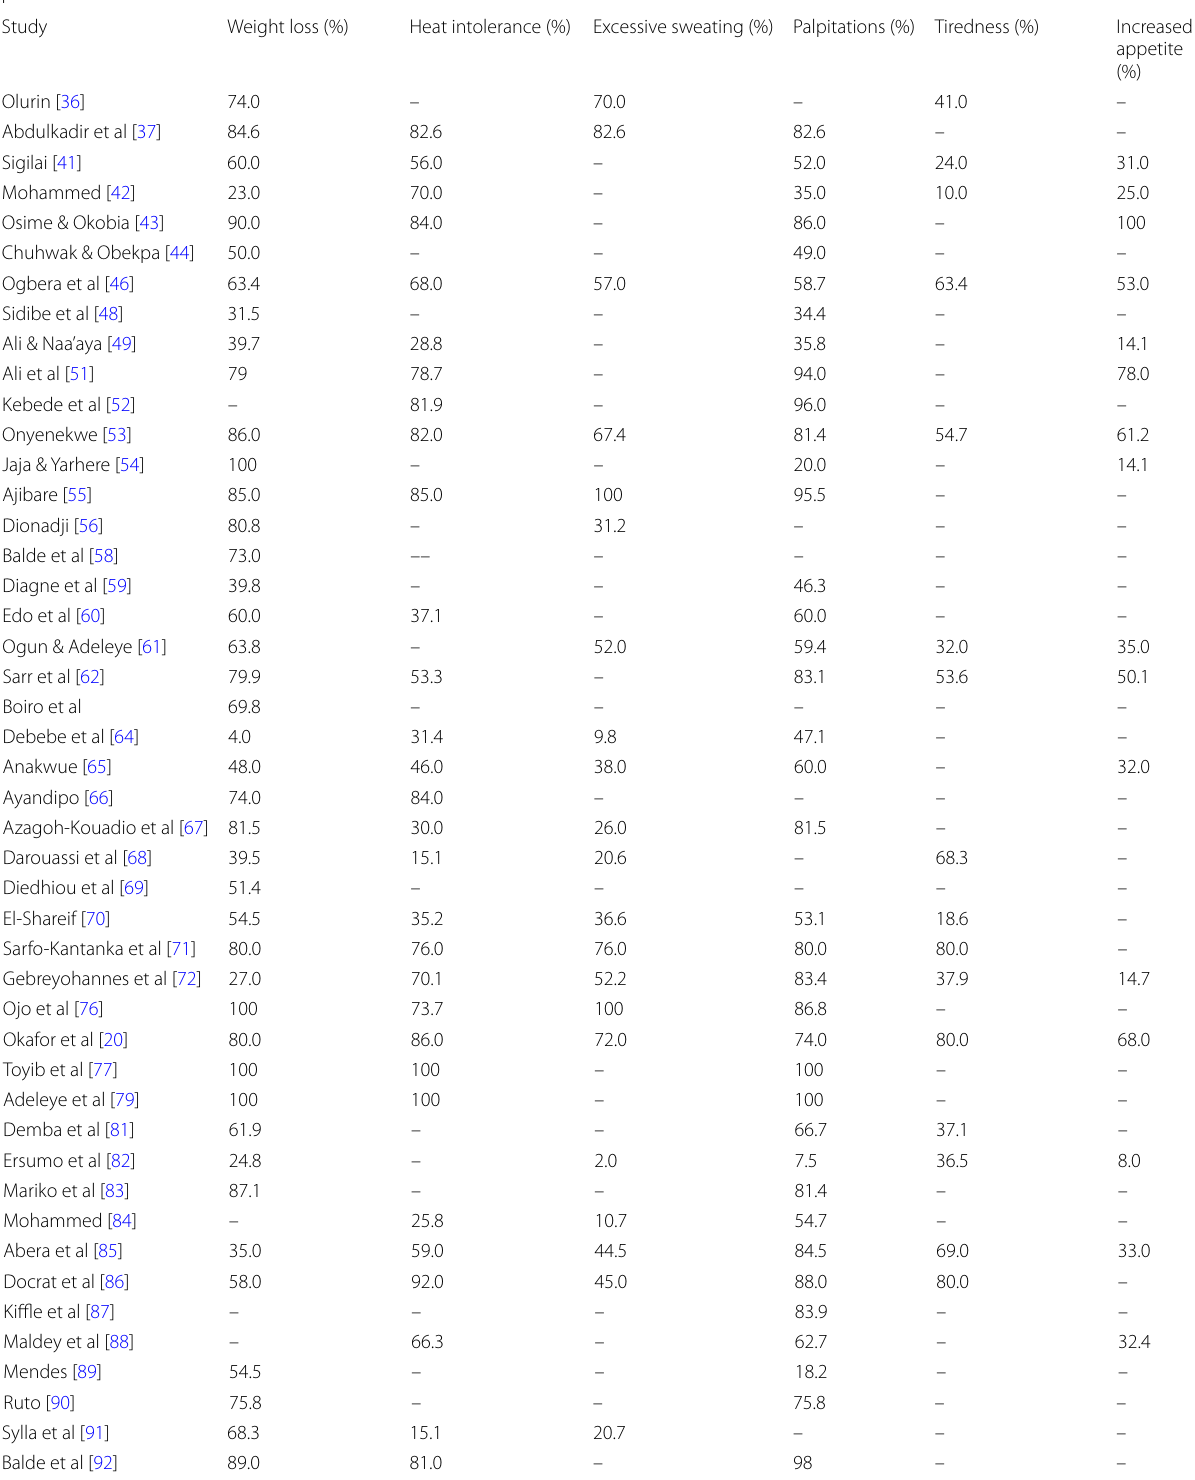
Table 5 Clinical features of thyrotoxicosis among African